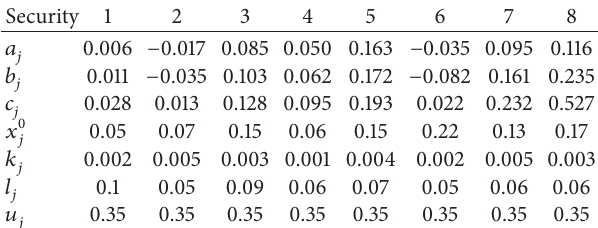
Algorithm 2: Chaotic initialization. Table 1: The zigzag uncertain returns of 8